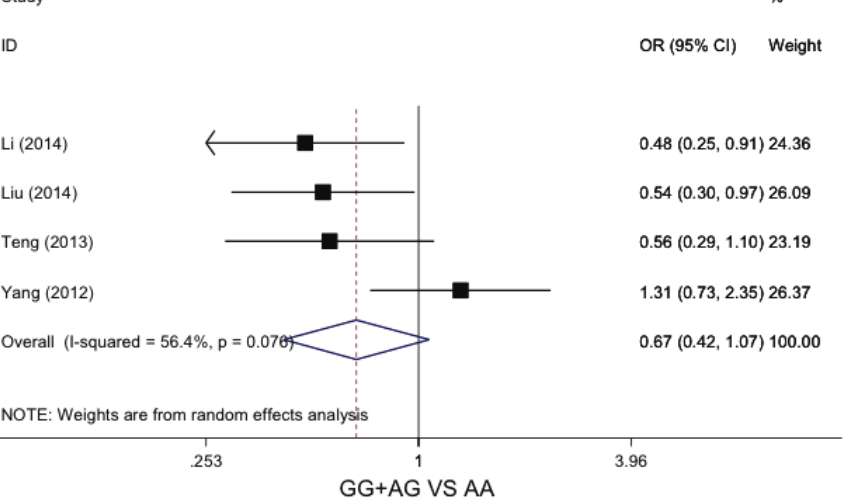
Figure 3: Forest plot of GSTP1 A>G polymorphisms and chemosensitivity of osteosarcoma in dominant genetic model (GG+AG vs AA)